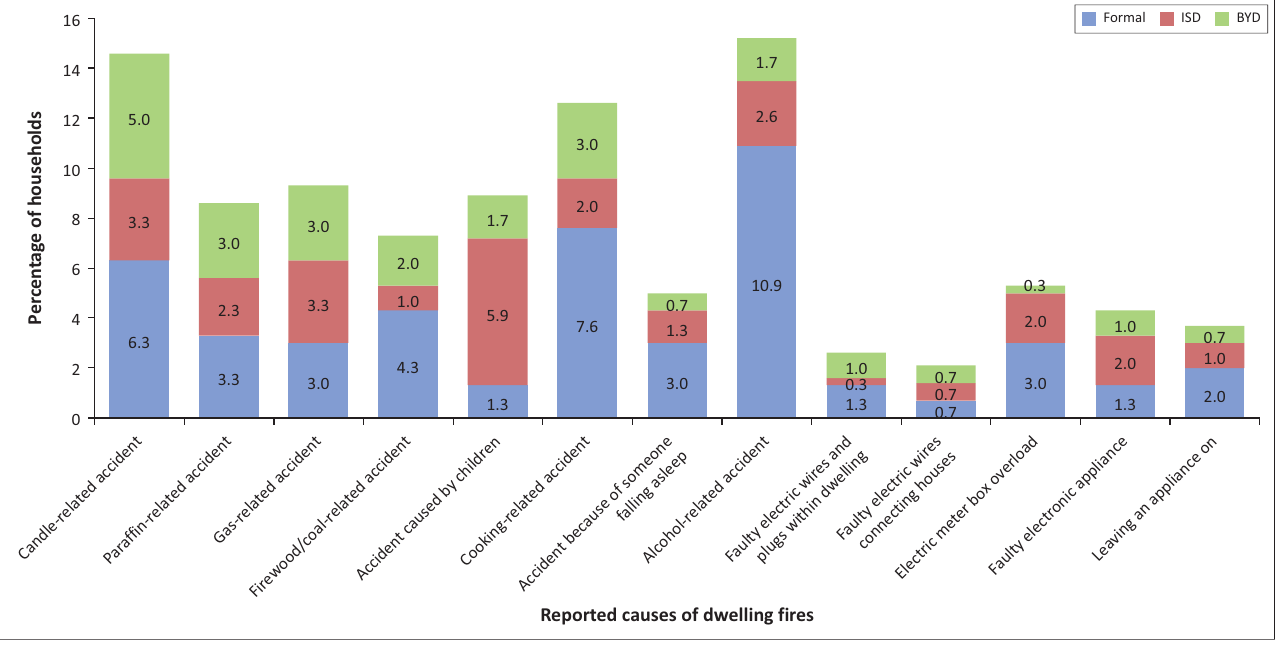
FIGURE 10: Reported causes of fires by households who have experienced one or more fire incidences.